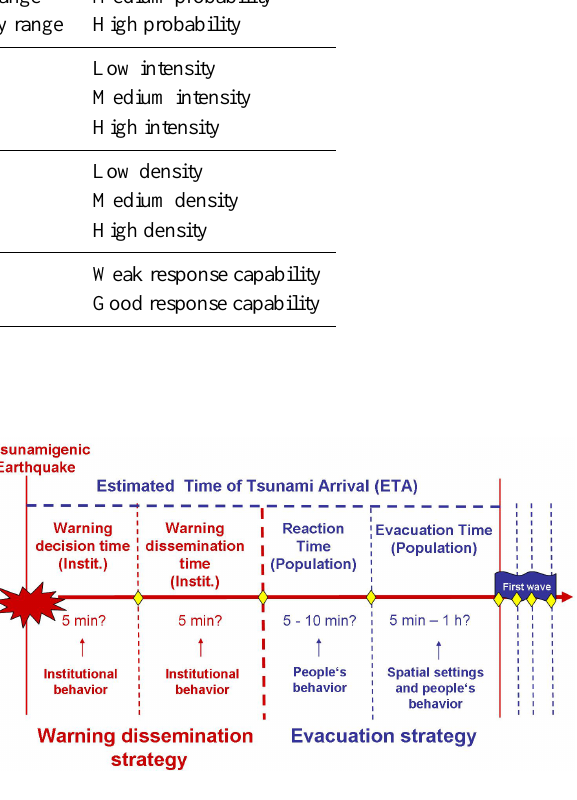
Fig. 3. Relevant time components for the assessment of human re- sponse capability to tsunami warning (Post et al.,